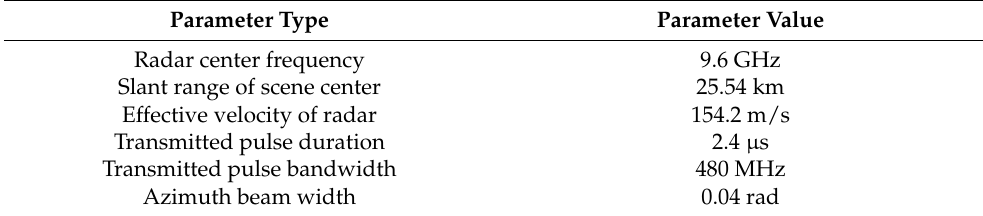
Table 1. Parameters of X-band side-looking airborne SAR